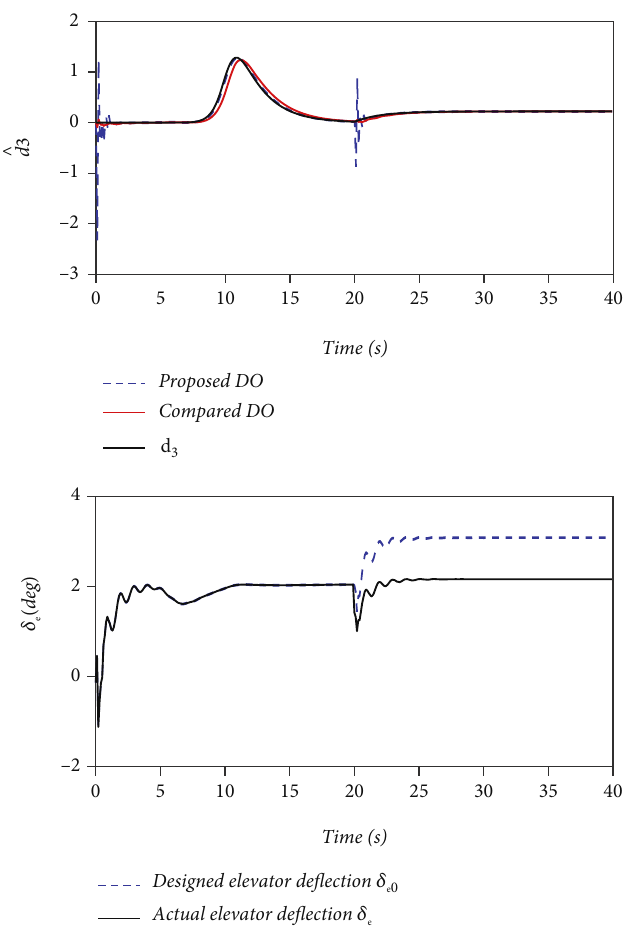
Figure 3: Estimation of d